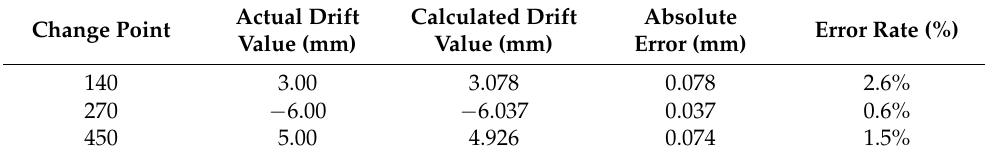
Table 1. Calculation results of drift values.